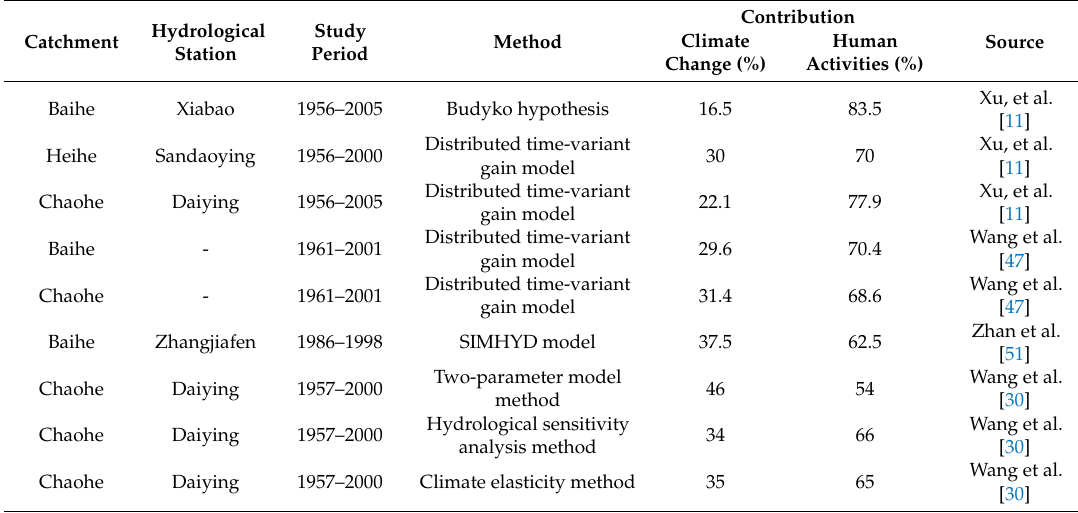
Table 4. Previous attribution studies on the streamflow change in the Chaobaihe River catchment.